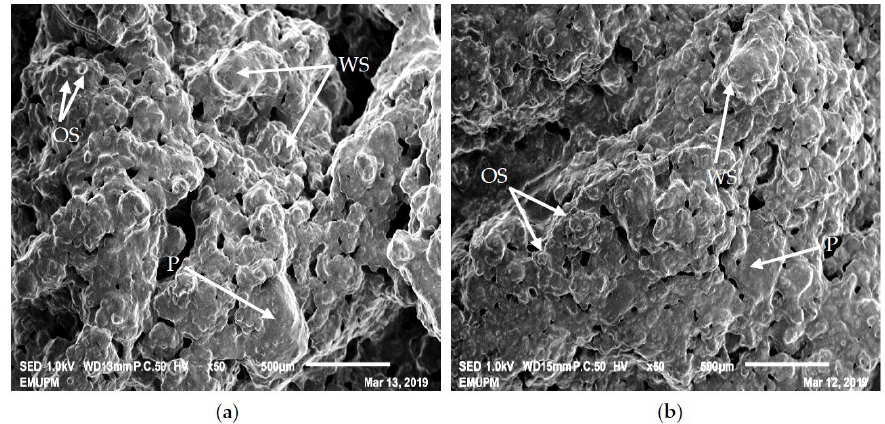
Figure 5. ( a ) Sample S3 (highest moisture content); ( b ) sample S13 (lowest moisture content) at 50 × magnification. OS: oat starch granules; WS: wheat starch granules; P: protein matrix.